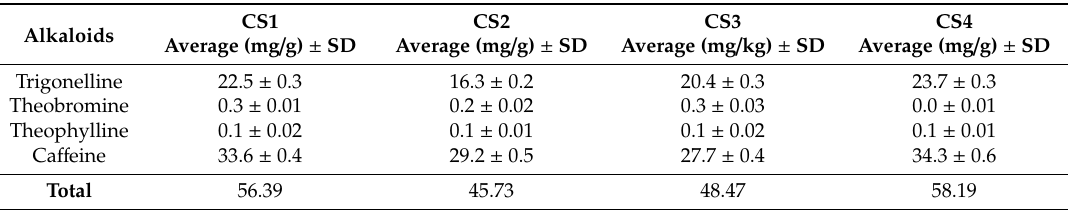
19.4 to 162.6%, from 19.1 to 211.1%, and from − 4.5 to 134.2% for ABTS, DPPH, and FRAP,